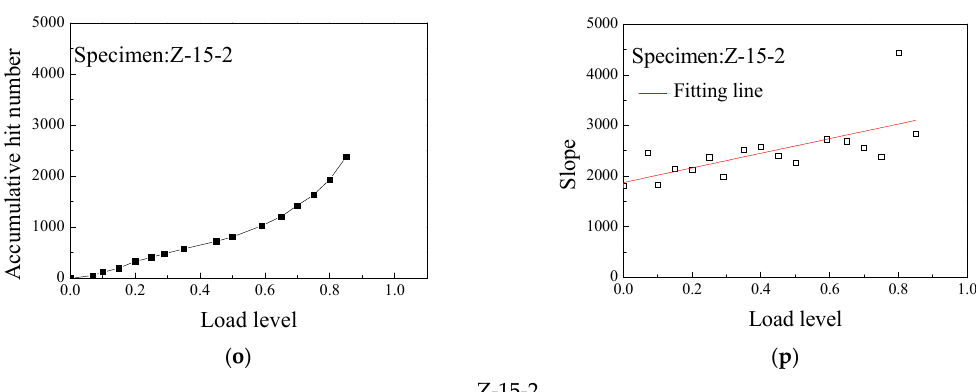
Figure 7. Load accumulative hit curve and slope curve for different corrosion rates (two specimens per corrosion rate).